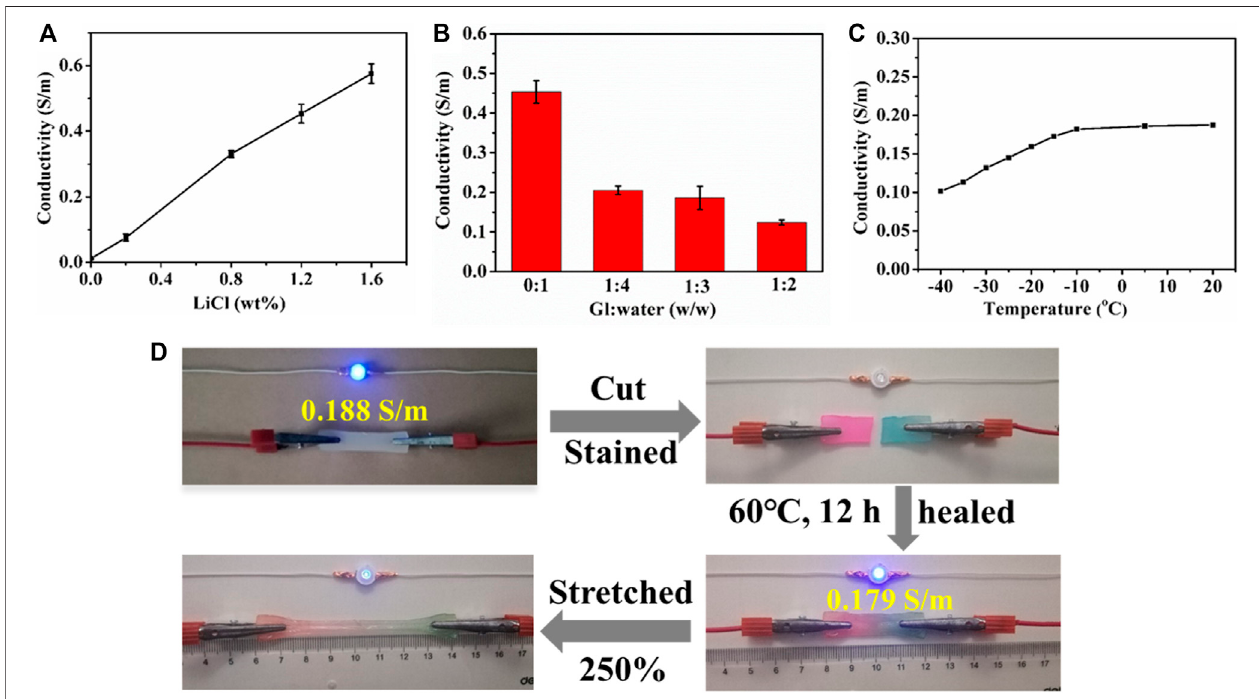
FIGURE 5 | The conductivity of PHEAA-GE-Gl-LiCl organohydrogels. Effect of (A) LiCl concentration, (B) the weight ratios of Gl/water, (C) temperature, and (D) circuit comprises an LED indicator connected by original, cut, self-healed, stretched self-healed PHEAA-GE-Gl-LiCl organohydrogel sheets.